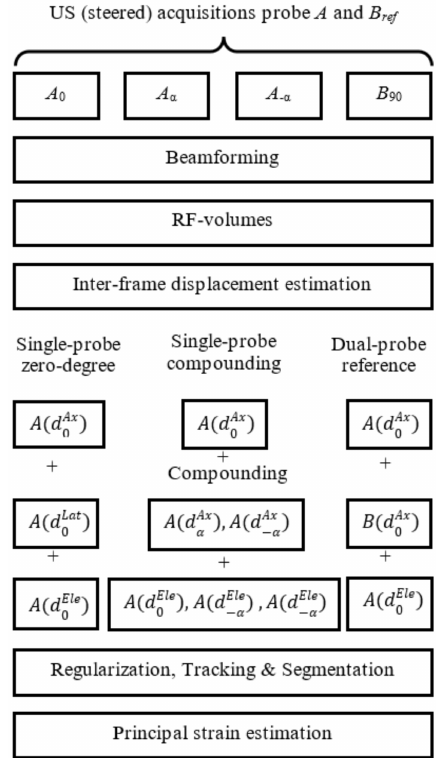
Figure 6. Flowchart indicating the in-line processes performed from the acquisitions to strain estimation to compare the single-probe compounding versus the single-probe zero-degree performance in terms of minimal (compressive) and maximum (tensile) 3D principal strains. Please note that this flowchart describes the situation with respect to probe A. A similar flowchart with respect to probe B was also applied and can be obtained by interchanging A and